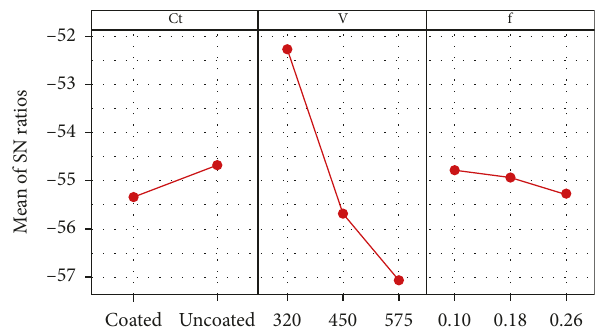
Figure 4: Effect of process parameters on average S/N ratio for C